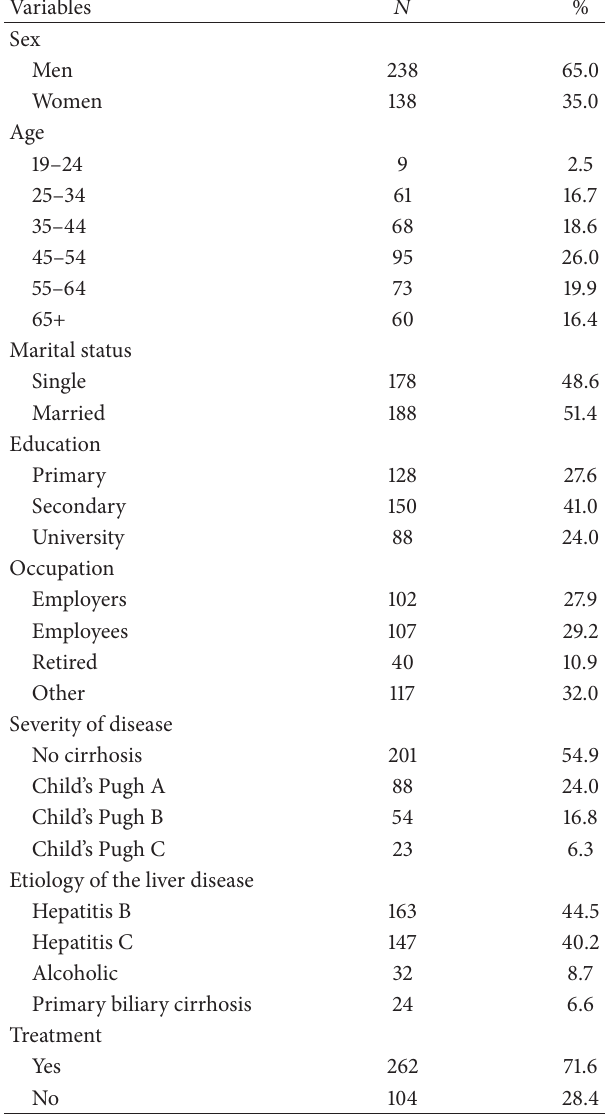
Table 1: Sociodemographic characteristics of the population